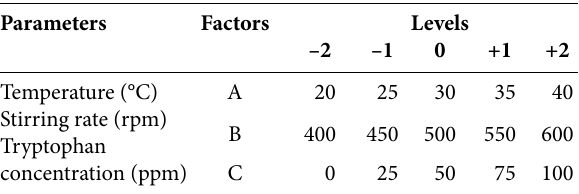
Table 3. Experimental variables and their levels in central compos- ite design matrix. Parameters